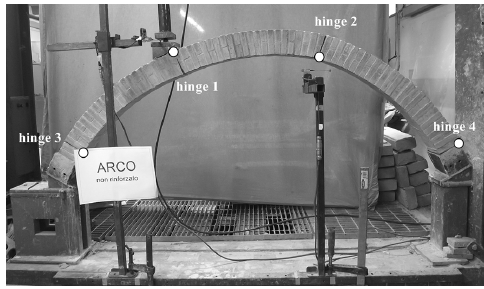
Figure 3. Hinges on the un ‐ strengthened arches.